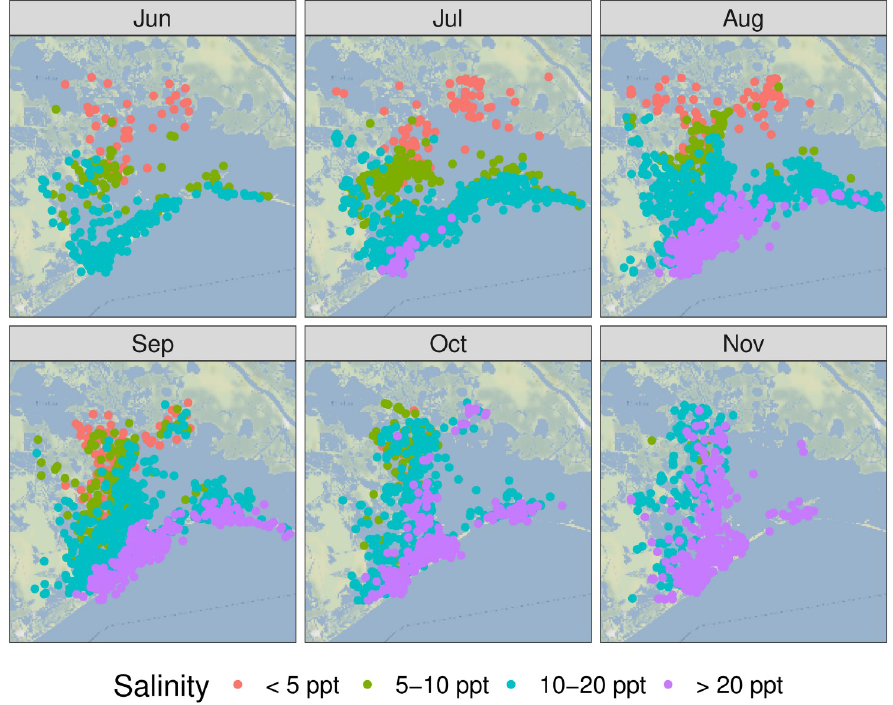
Fig 3. Estimated salinity at telemetry locations/timepoints from 2011–2017. We binned the Delft3D modeled salinity for each telemetry transmission and plotted transmission locations for all individuals. Dolphins at locations with model estimates with low salinities (e.g., < 5 ppt [parts per thousand]) tend to be in the northern part of the basin during the summer months. Map tiles used with permission from Stamen Design, under a CC BY license. Data by OpenStreetMap, under ODbL.